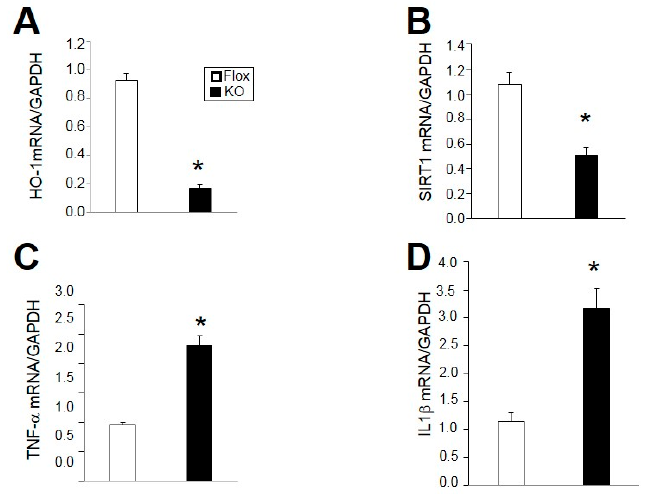
Figure 8. Gene expression levels of: ( A ) heme oxygenase-1 (HO-1); ( B ) Sirtuin-1 (SIRT1); ( C ) Tumor necrosis factor- α (TNF- α ); and ( D ) Interleukin-1 β (IL1 β ) in adipose of male mice after 30 weeks high fat diet. * p < 0.05 compared to the corresponding value in Flox mice. n = 4/group.